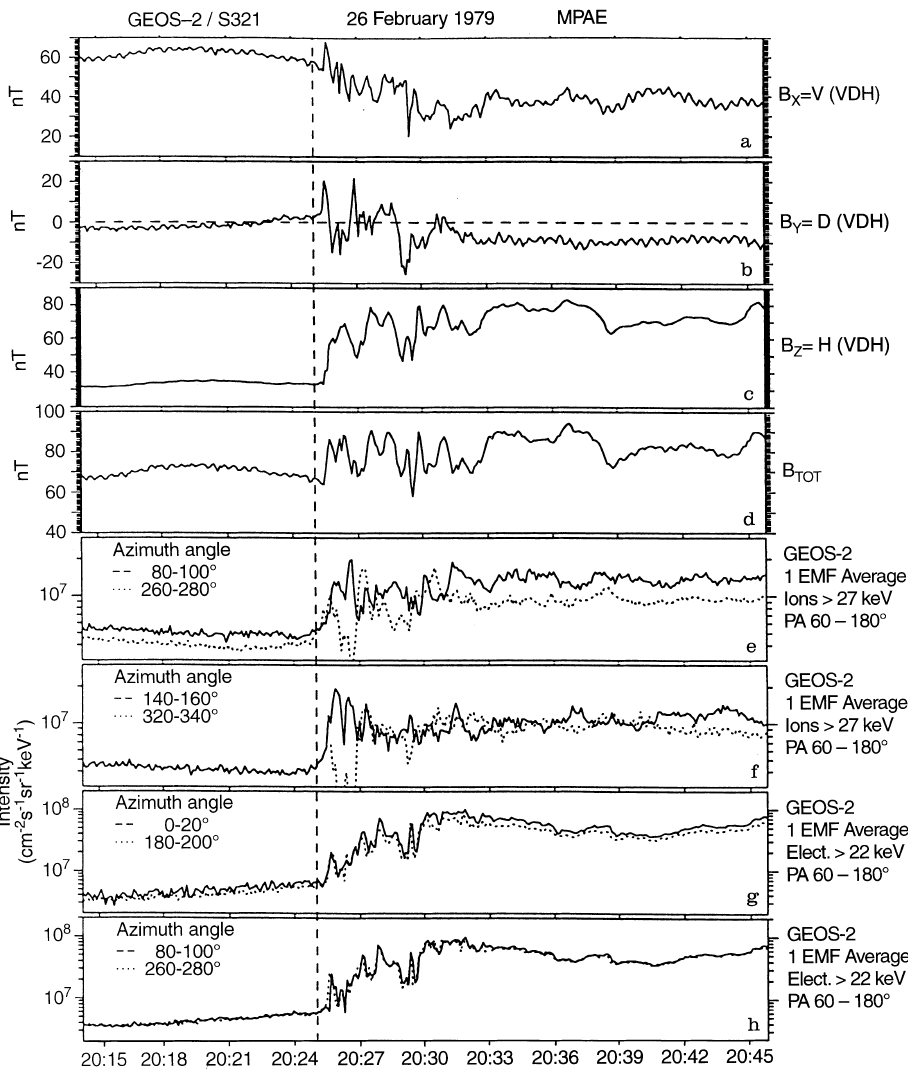
Fig. 3a – h. Event on 26 February 1979: a – d magnetic field in VDH components, e and f integral ions at two opposite azimuths, g and h integral electrons at the opposite azimuths